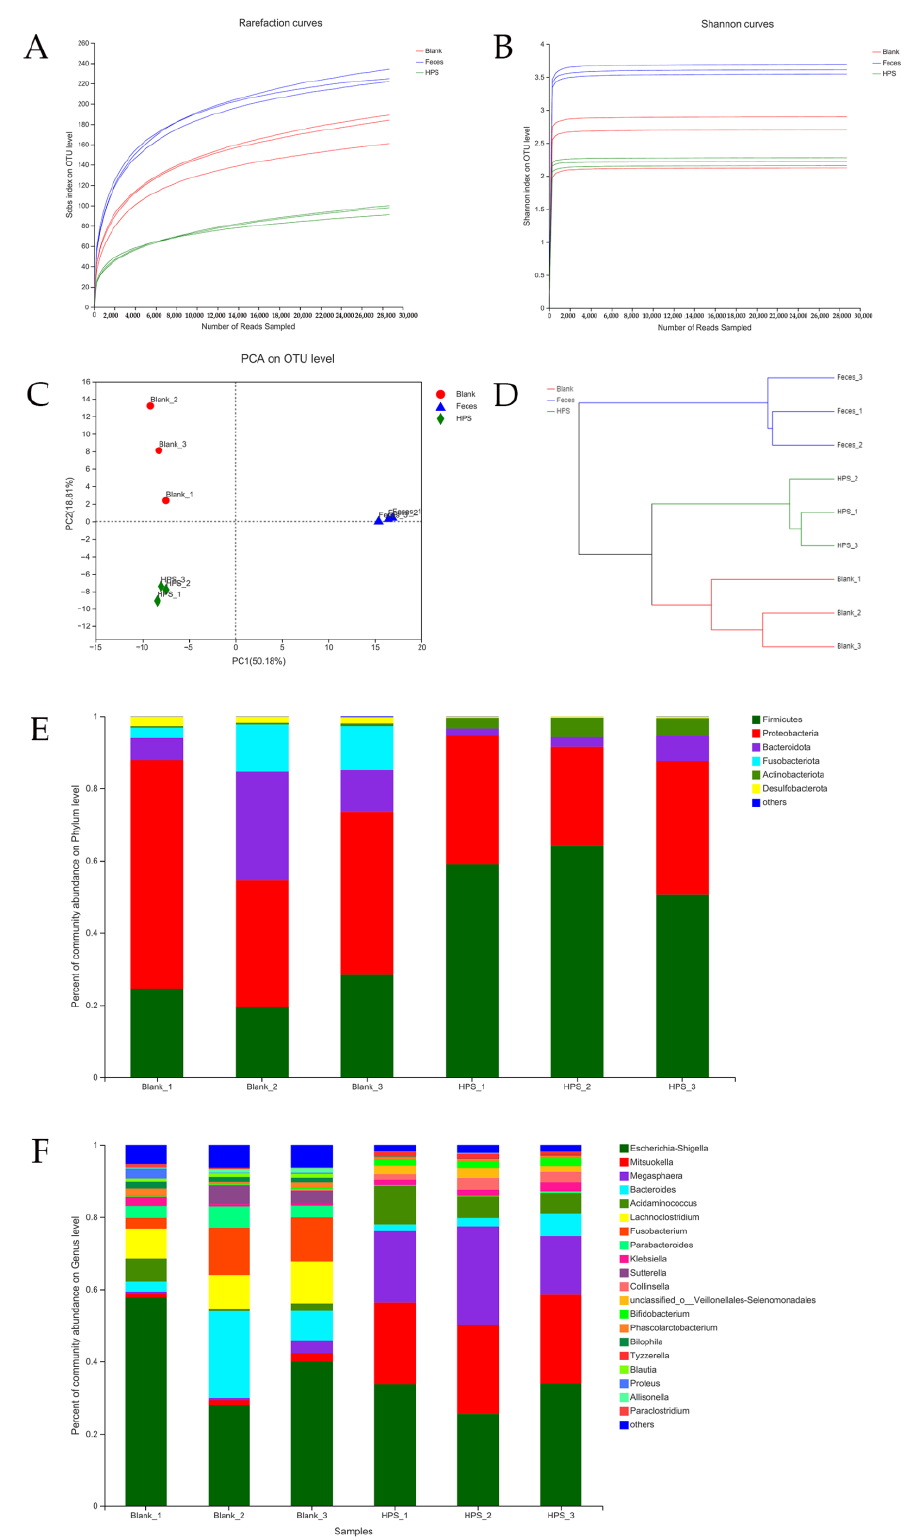
Figure 5. Rarefaction curves ( A ), Shannon curves ( B ), and principal component analysis ( C ) and unweighted UniFrac cluster tree ( D ) of gut microbiota of Blank, Feces, and HPS samples during in vitro digestion. Plots showed the changes in human gut microbiota in phylum level ( E ) and genus level ( F